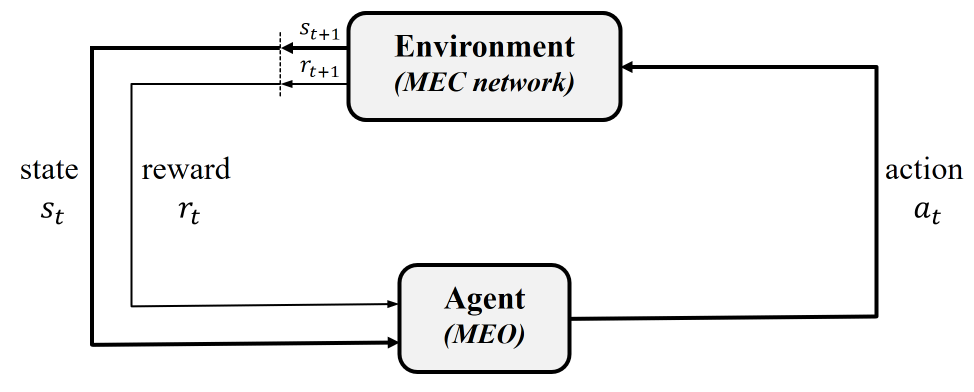
Figure 4. Agent–environment interaction in the